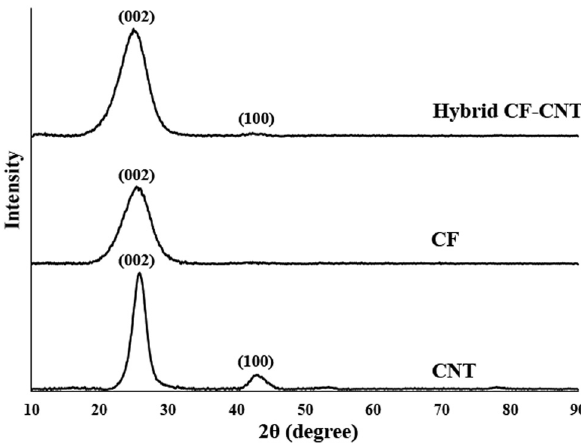
Figure 4: XRD patterns of CNT, CF and hybrid CF – CNT.